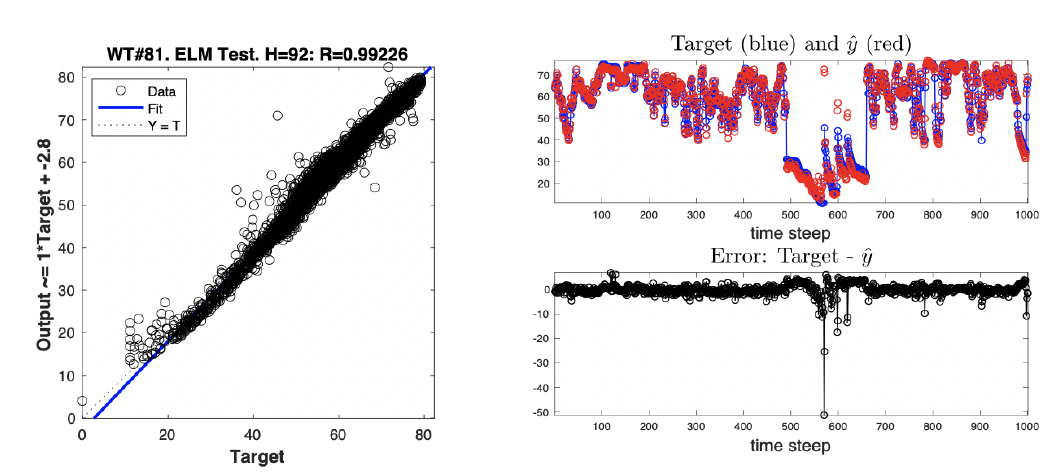
Figure 9. Test of the selected model ( H = 92) for the WT#81. ( Left ) the regression plot using all the test data. ( Right ) from a temporal window where the target ˆ y ( top ) and the error ( bottom ) can be observed in more detail.